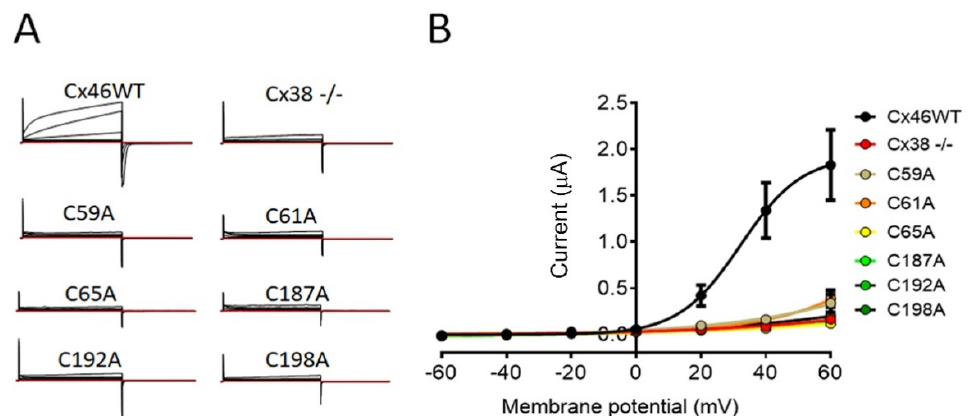
Figure 4. Hemichannels formed by Cys mutants are insensitive to membrane depolarization. Xenopus oocytes were injected with an oligo against the endogenous Cx38 alone (Cx38 -/-) or in combination with cRNA of wild-type Cx46 or Cys mutants. Hemichannel currents were recorded using dual-electrode voltage clamp after 24 h in 8 oocytes. ( A ) Representative recordings showing that only hemichannels formed of wild-type Cx46 open after membrane depolarization. ( B ) I/V plot summarizing results of the 8 independent experiments. The Boltzmann equation was used to fit current values.